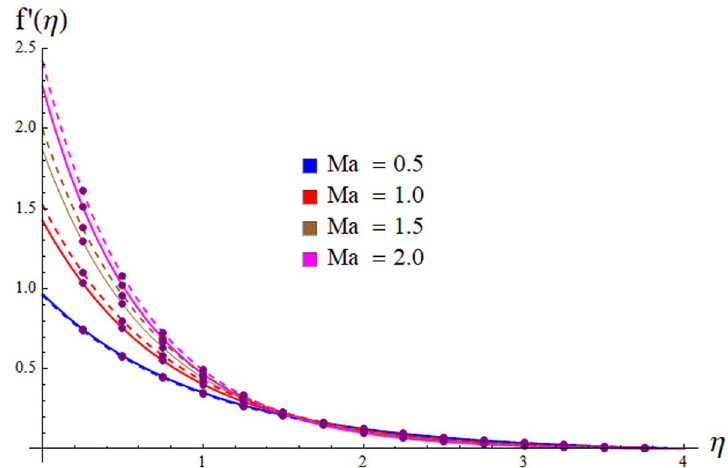
Figure 2. Behavior of velocity f ′ (η) against Ma = 0.5,1.0,1.5, 2.0.